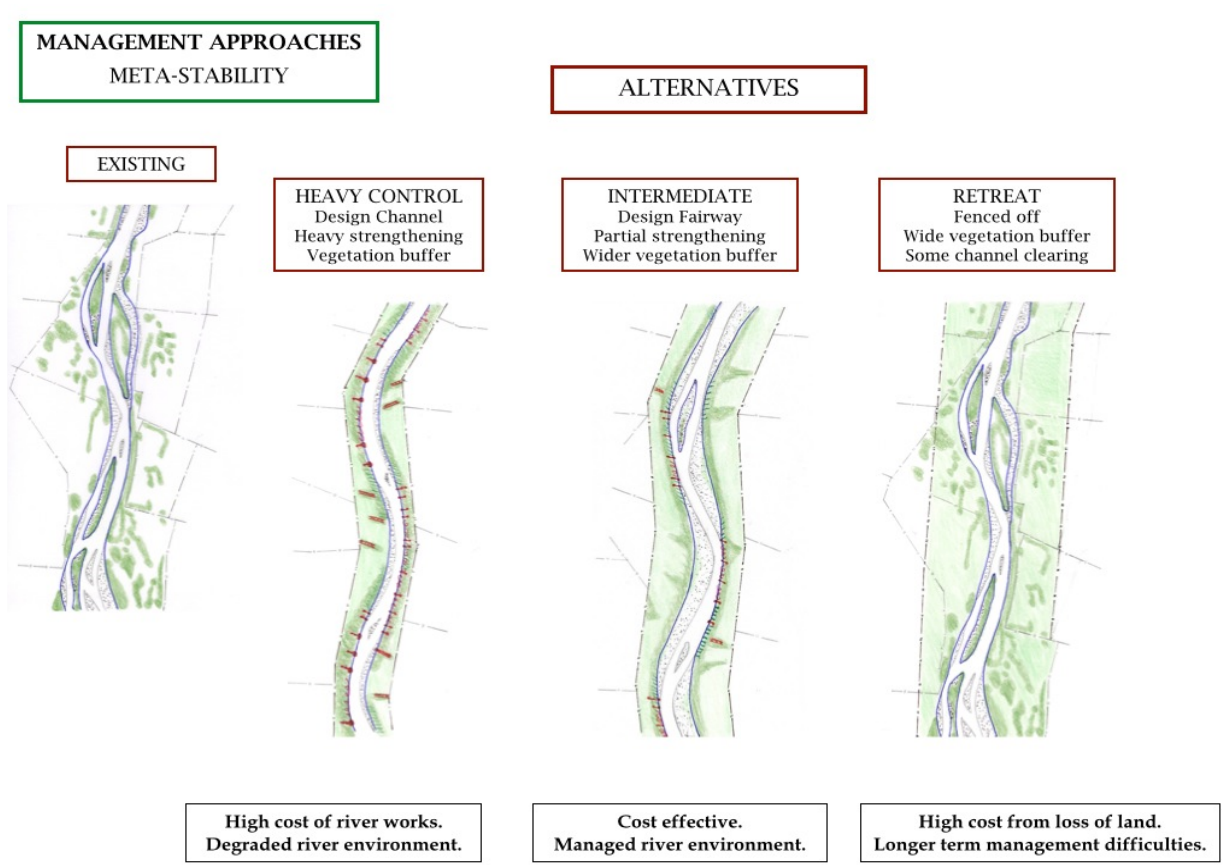
Figure 2. Management options for riparian corridors conceived through a command-and-control lens [55] . See text for details.